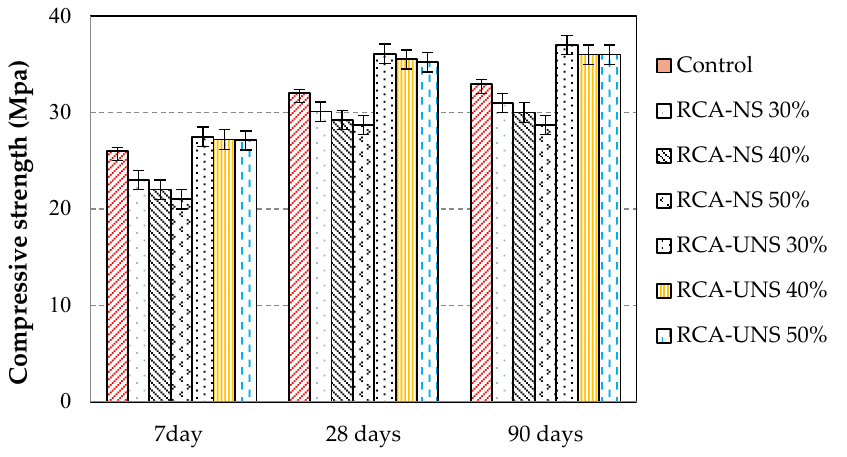
Figure 6. Compressive strength test of samples.